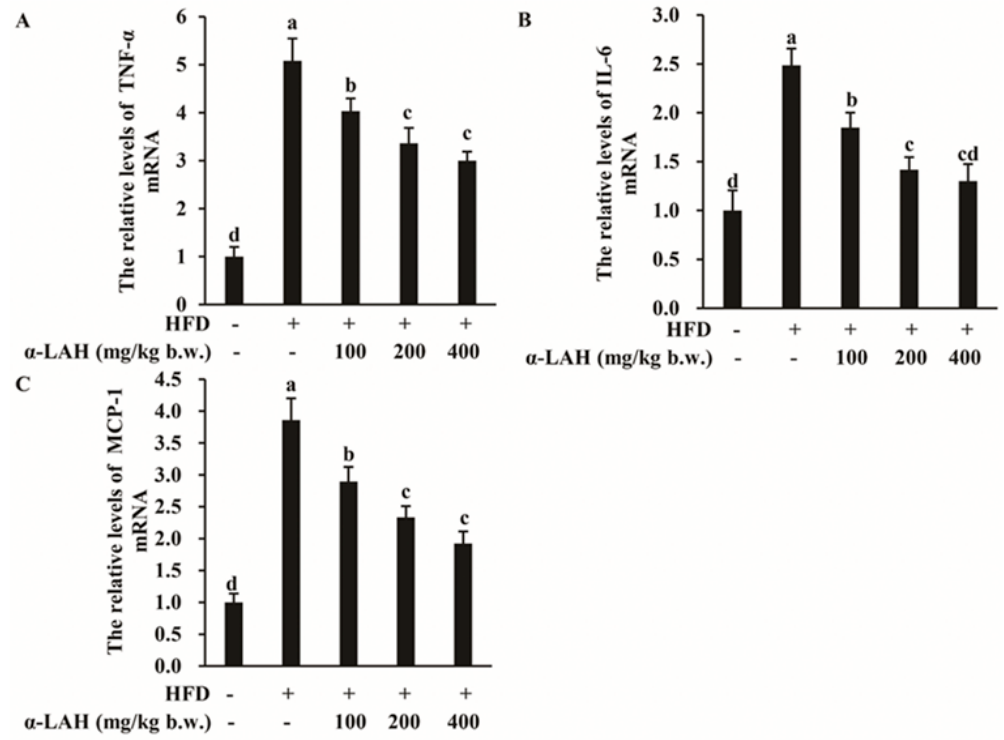
Figure 5. Effect of bovine α -lactalbumin hydrolysates ( α -LAH) supplementation on inflammation-related gene expression in epididymal adipose tissues of mice fed with high-fat diet. ( A ) Relative levels of tumor necrosis factor (TNF)- α mRNA expression in epididymal adipose tissues; ( B ) relative levels of interleukin (IL)-6 mRNA expression in epididymal adipose tissues; ( C ) relative levels of monocyte chemoattractant protein (MCP)-1 mRNA expression in epididymal adipose tissues. All data were presented as means ± standard deviations (SD) ( n = 6). Significance was determined by one-way analysis of variance (ANOVA) with the Duncan’s multiple-comparison test, and mean values without common letters indicate differences at p < 0.05.